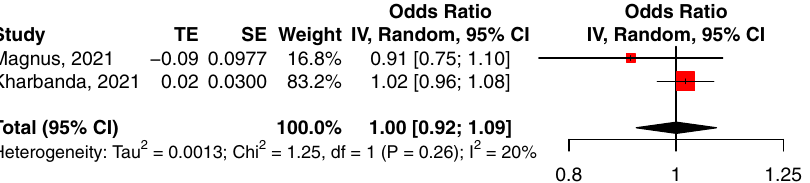
Fig. 6 Forest plot of studies reporting miscarriage rate and accounting for time-varying confounding. Vertical ticks within the red boxes and horizontal lines show the mean effect and 95% con fi dences interval for each study. Black diamond at the bottom shows the cumulative effect with 95% con fi dence